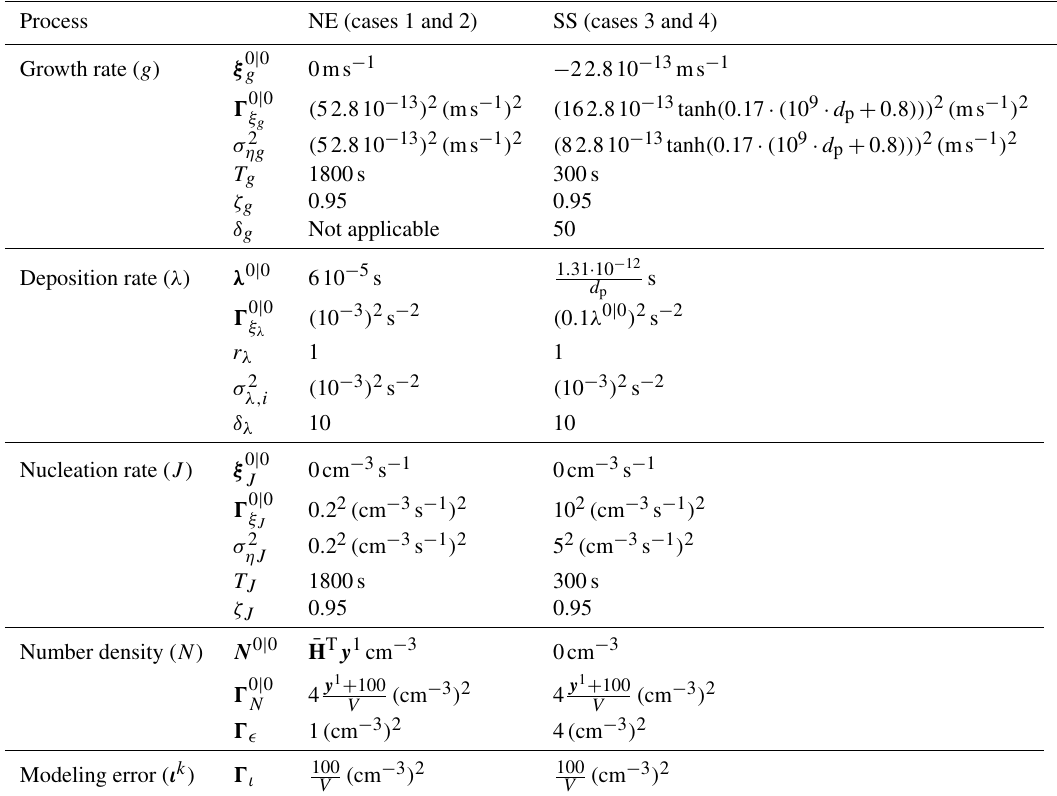
Table B2. Parameters used in state estimation for nucleation event (NE) and steady-state (SS) cases. Process NE (cases 1 and